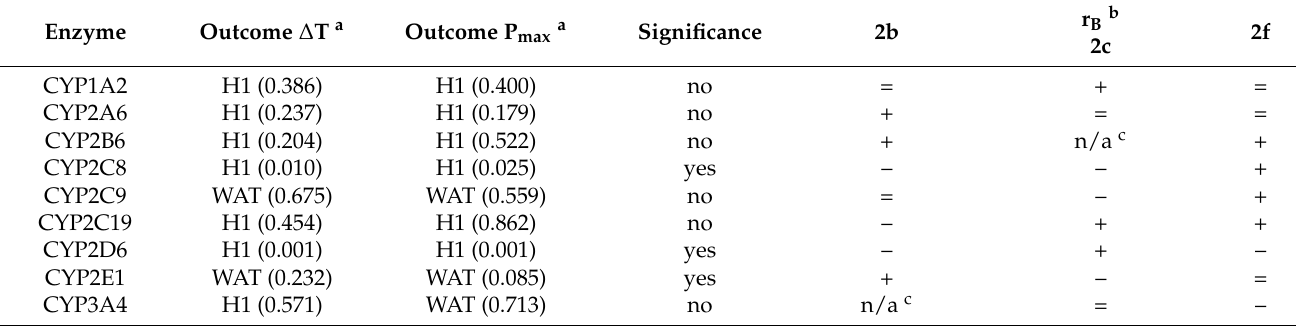
Table 2. Statistical analysis of metadynamics